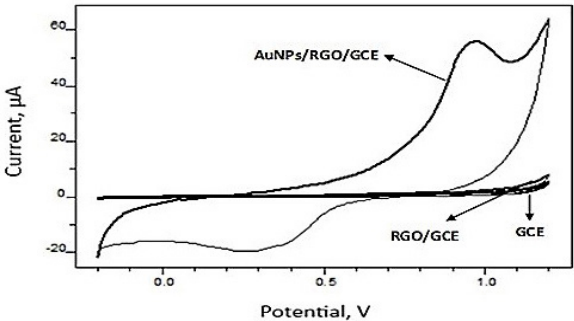
Figure 6. The cyclic voltammograms of 1.50 × 10 –3 mol L –1 ziram in BR buffer solution with pH 8.0 at scan rate 0.050 v s –1 , for the bare GCE, RGO/GCE and